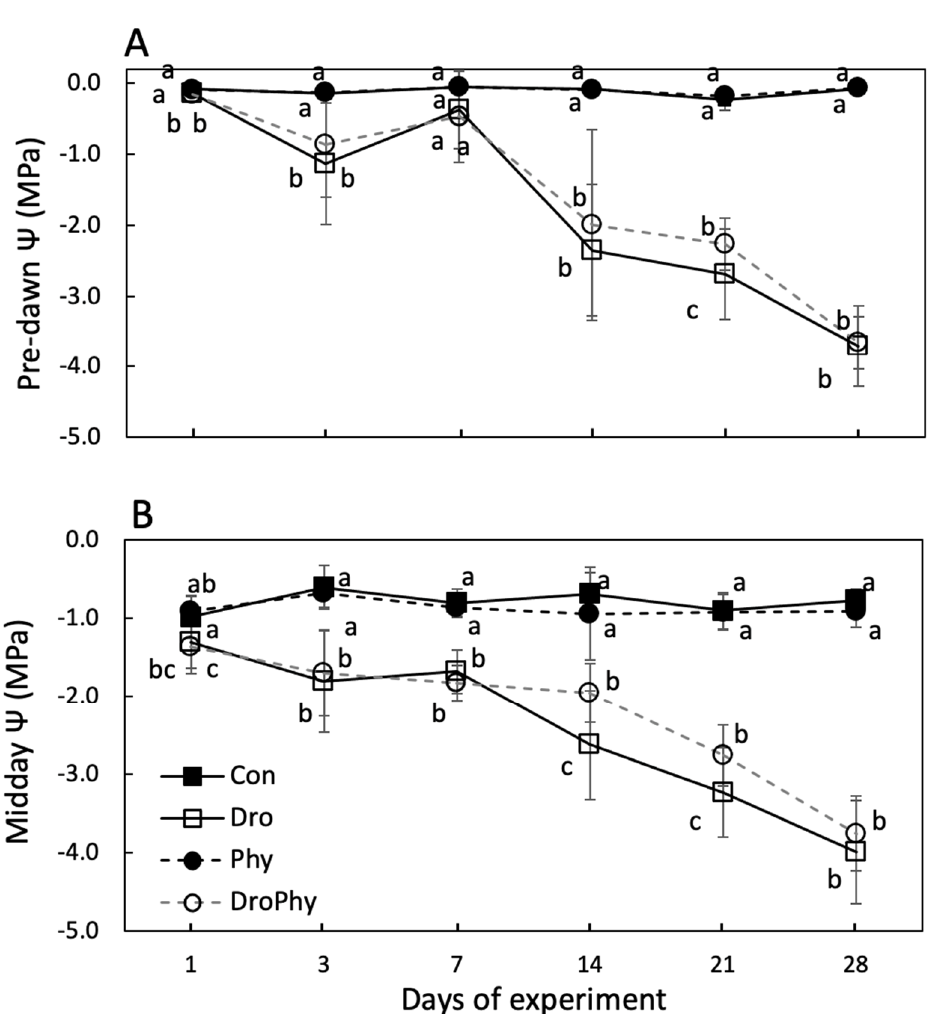
Figure 2. ( A ) Pre-dawn ( Ψ pd ) and ( B ) midday ( Ψ md ) water potentials (MPa) of E. obliqua seedlings subjected to Control (Con), Drought (Dro), Phytophthora (Phy), and Drought- Phytophthora (DroPhy) treatments for five weeks. Error bars indicate ± standard error of the mean values; where no error bars are visible, the values are smaller than the symbol. Means with different letters are significantly different at p ≤ 0.05, after ANOVA and LSD test.